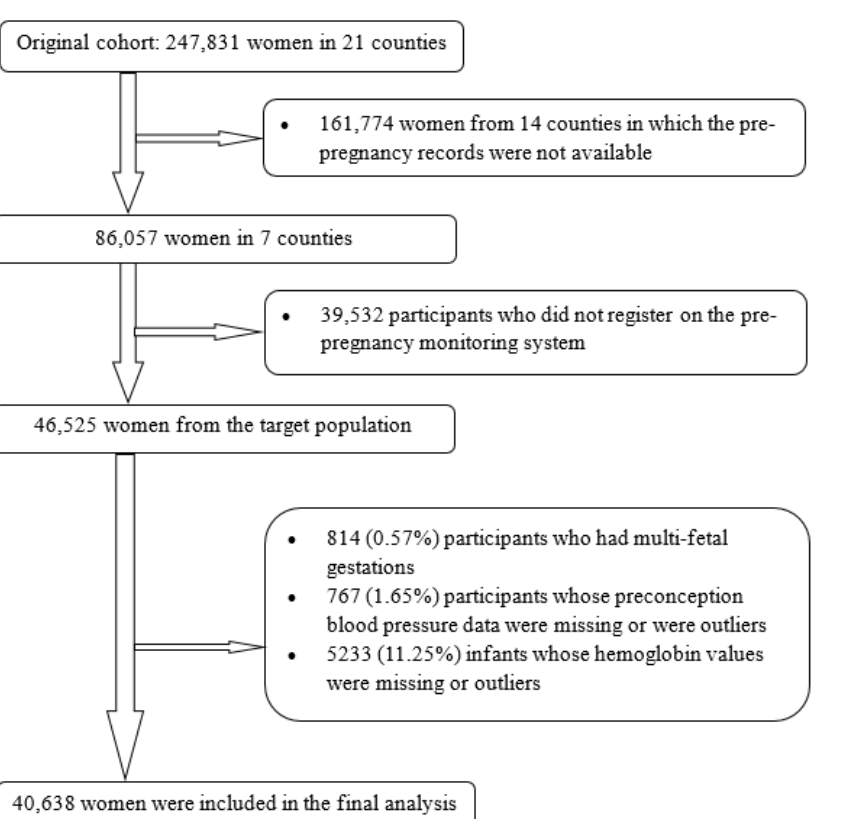
Figure 1. Flowchart of participants.